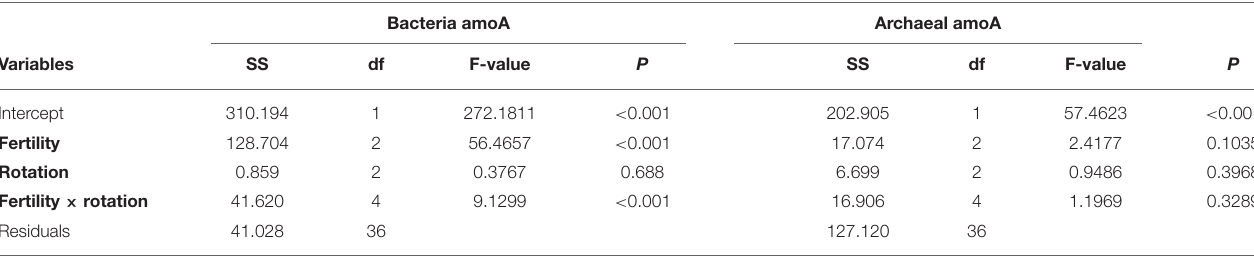
TABLE 3 | Two-way Analysis of Variance (ANOVA) for model assessing the influence of fertility and rotation on quantitative polymerase chain reaction (qPCR) ammonium oxidation gene abundances.